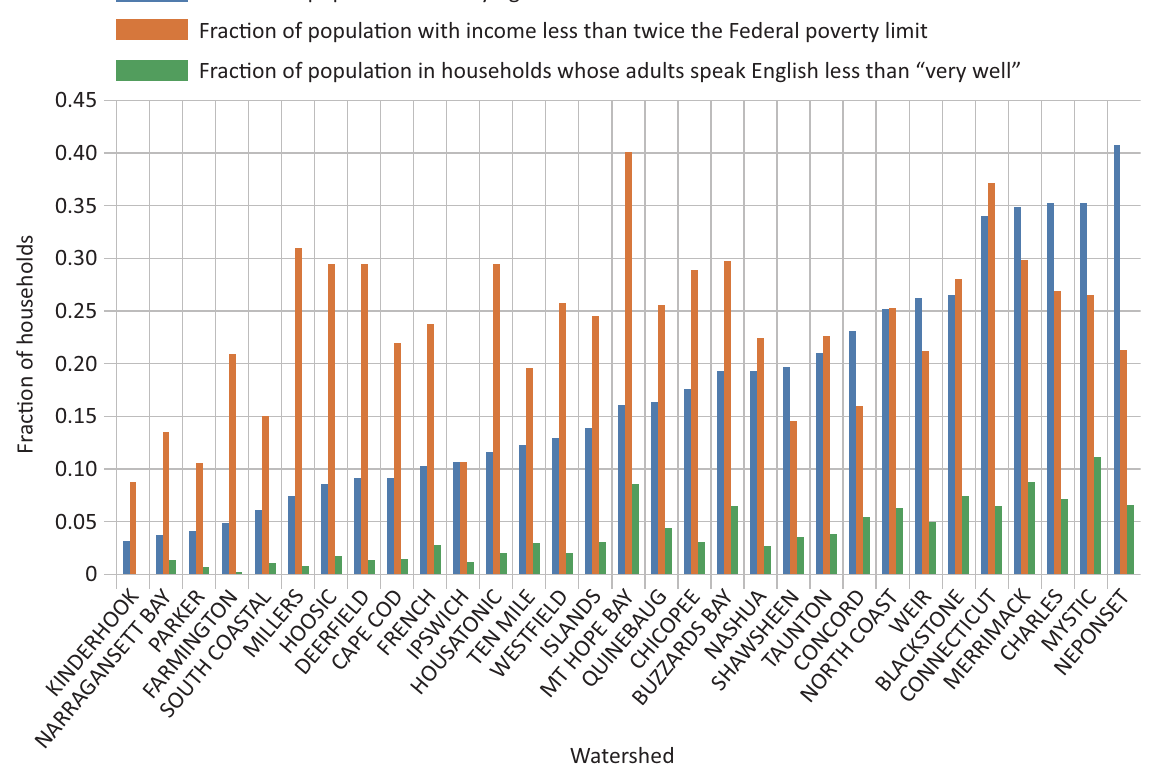
Figure 2. Distribution of EJ characteristics across Massachusetts watershed populations. environmental agency reporting data, estimates based on models operated by municipalities, or regional util- ity operators.